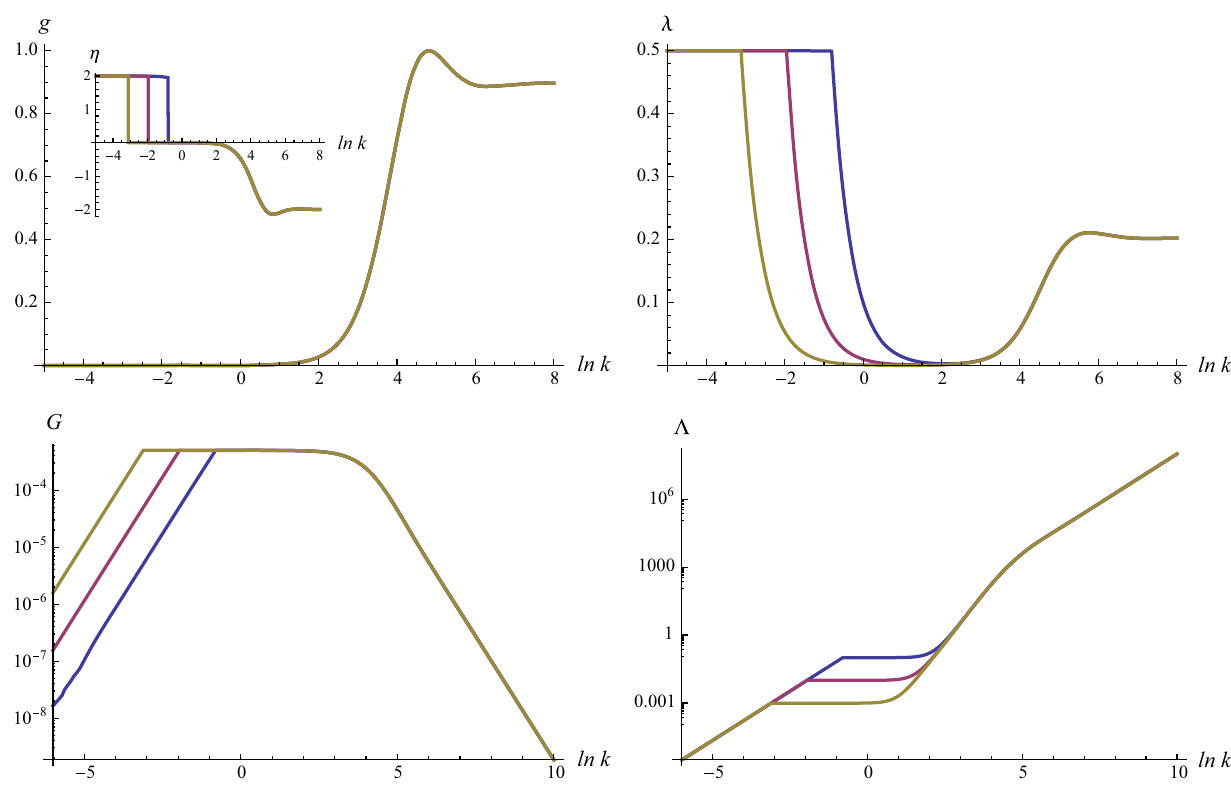
Fig. 4 Sample RG trajectories obtained from solving the flow equa- tions for α = 0 and a Type II 0 regulator for the initial conditions g init = 0 . 0005 and λ init = 10 − 1 ( blue line ), λ init = 10 − 2 ( magenta line ), and λ init = 10 − 3 ( gold line ). For k → ∞ the trajectories are